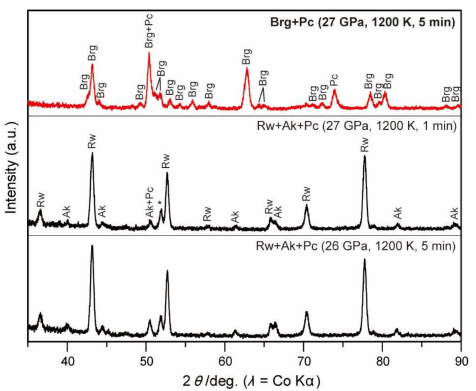
Figure 5. Preparation of the starting material of bridgmanite (Brg) + periclase (Pc). After trial runs changing pressure, temperature, and time, the synthesis condition was determined to be 27 GPa and 1200 K for 5 min ( top ). Akimotoite (Ak) and ringwoodite (Rw) appear when the synthesis pressure and heating time is lower and shorter,